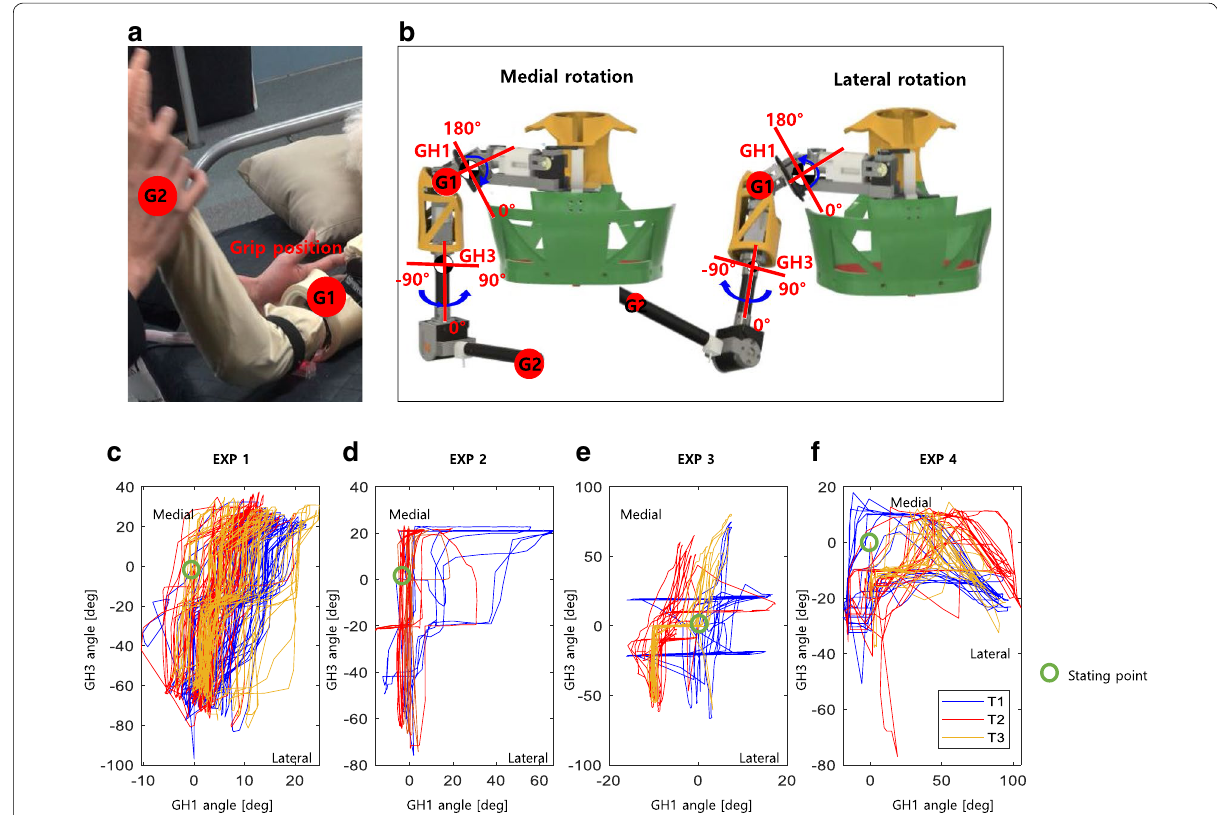
Fig. 10 Example of glenohumeral joints in lateral and medial rotation (LD) exercise from the experts: a explanation of grip positions; b mechanism of elevation and depression; c angle curves between SC1 and GH2 joints. EXP expert, GH glenohumeral joint, Tn the number of tests. The green circle indicates the starting point of the